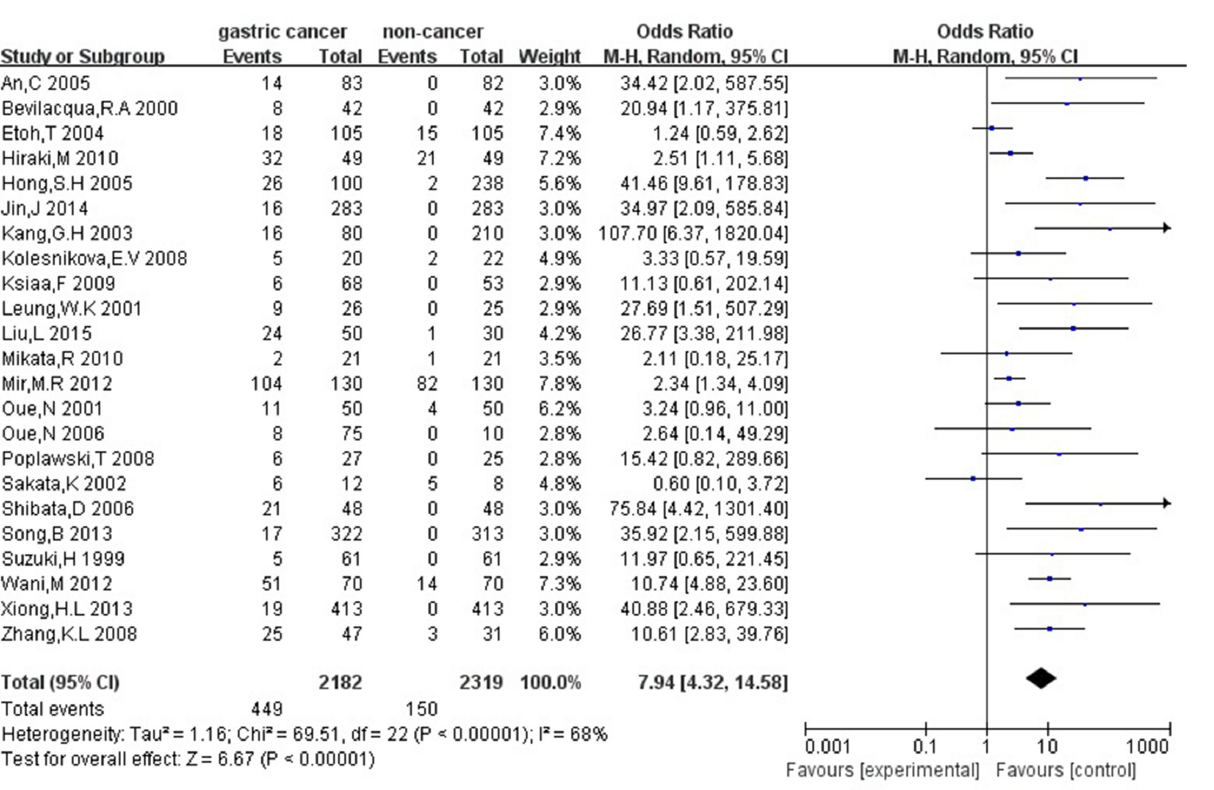
FIGURE 2 | Forest plot concerning hMLH1 methylation and gastric cancer risk. The squares and horizontal lines represent the corresponding OR and 95% CI for each study. The area of the squares reflects the weight of each study. The diamond represents the pooled OR and 95% CI. Random-effect model was used.